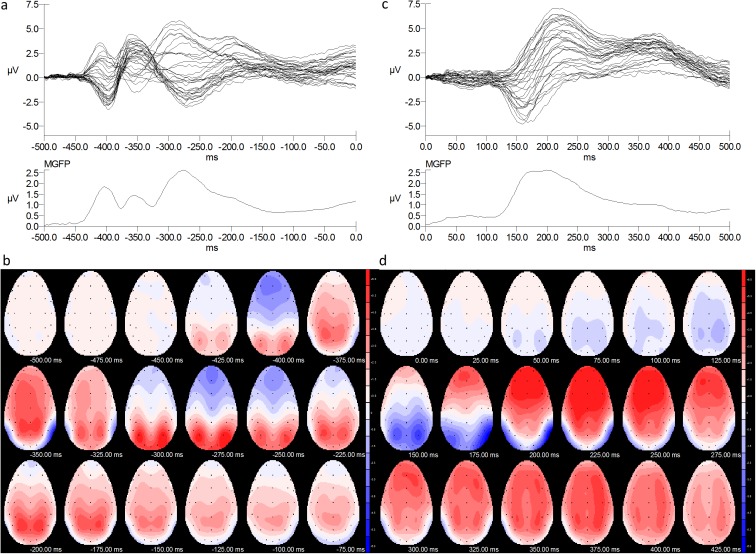
Comparison of ERP responses to onset of an angry face and transition from neutral to angry expression.Butterfly and mean global field power (MGFP) plots are shown at the top of the figure for angry face onset at -500 ms (a) and neutral-angry transitions at 0 ms (c). The corresponding ERP scalp distributions are shown in the lower half of the figure, sampled at 25 ms intervals from onset of an angry face (b) or from the transition from neutral to angry (d).